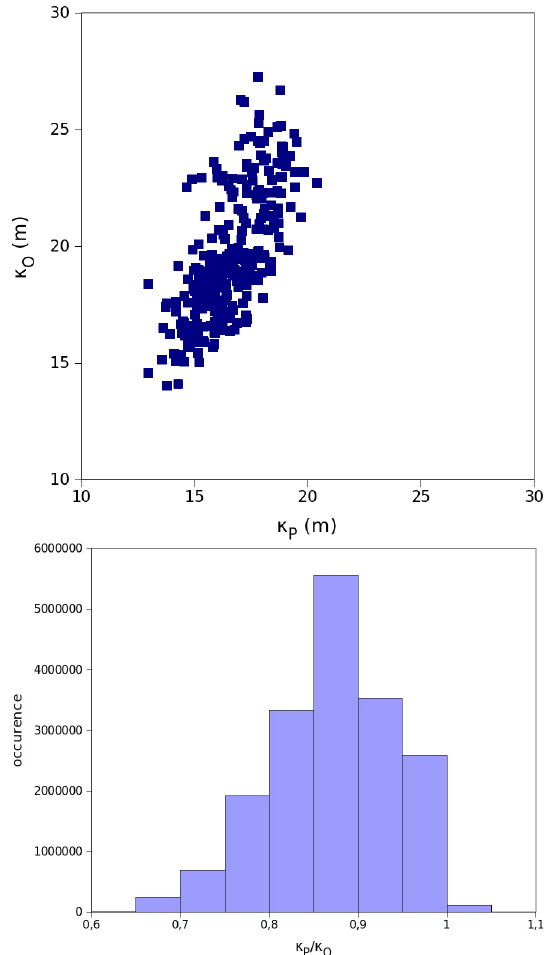
Fig. 5. (a) κ P vs. κ O diagram for experiments selected by the Metropolis–Hastings algorithm. (b) Probability histogram for the κ P / κ O ratio in the experiments selected by the Metropolis–Hastings